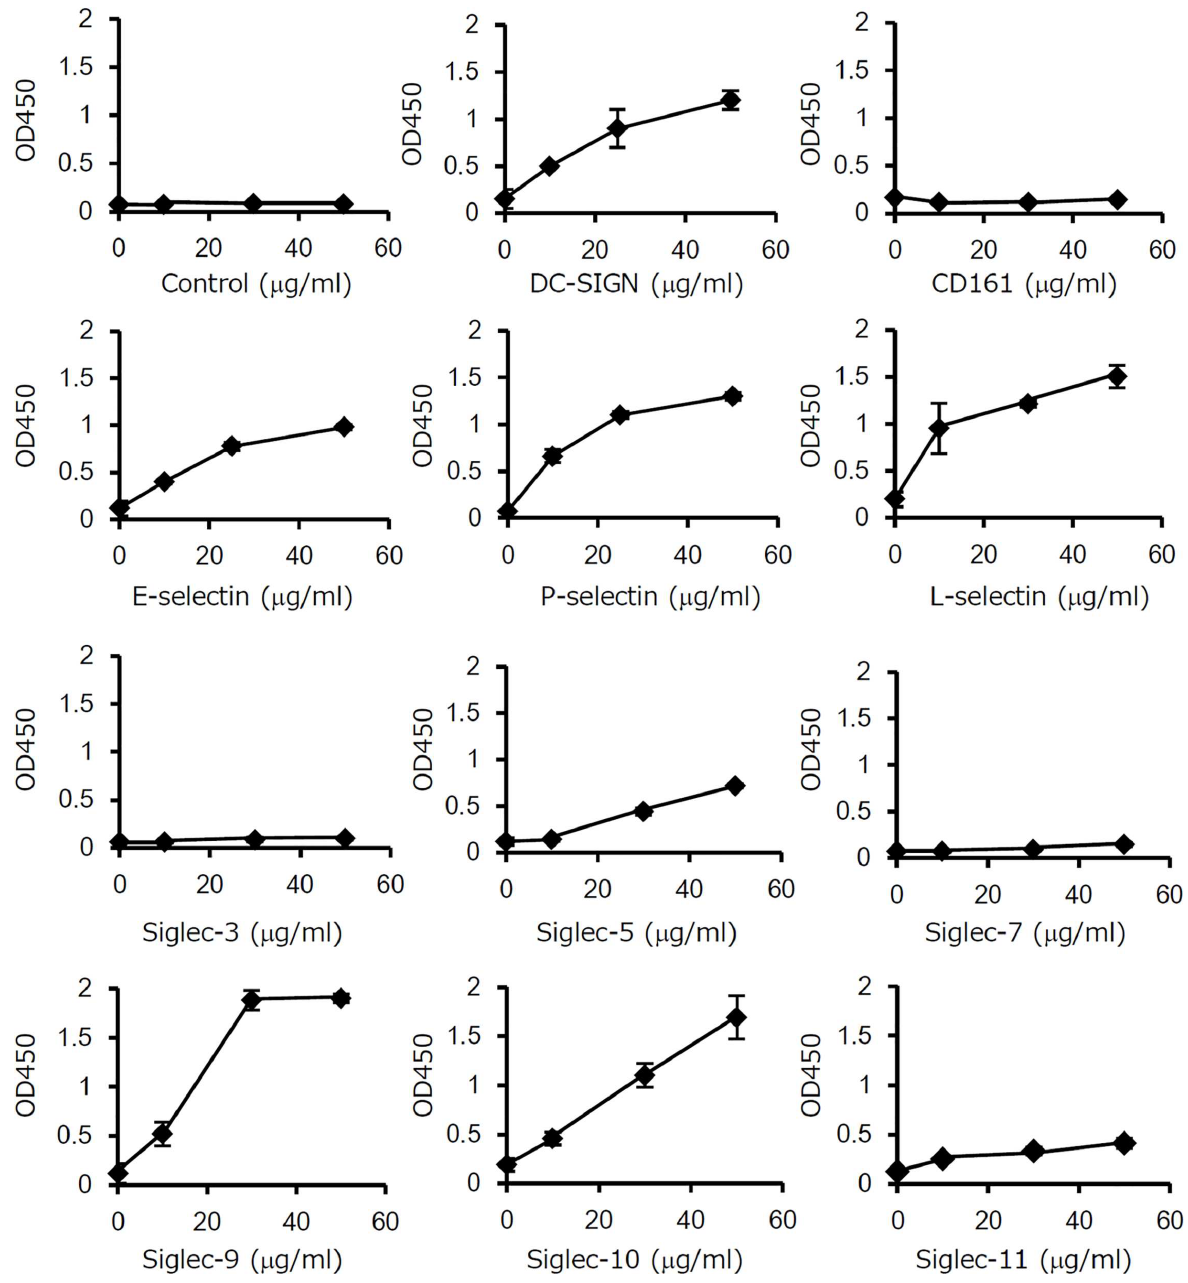
Fig 5. OmpA-like protein binds to lectins expressedon host cells. The wells of 96-well microtiter plates were coated with 5 μ g/ml OmpA-like protein for 18–24 h. After blocking, the wells were incubated with Fc-conjugated recombinantprotein (control IgG1, E- selectin, P-selectin, L-selectin, Siglec-3, Siglec-5, Siglec-7, Siglec-9, Siglec-10, Siglec-11, DC-SIGN, or CD161) at 10, 30, and 50 μ g/ml for 3 h. IgG1/Fc was used as a negative control. Bindingwas determined by ELISA using anti-humanIgG Fc secondary antibody conjugatedwith HRP. The results are expressed as the mean ± SD (n =